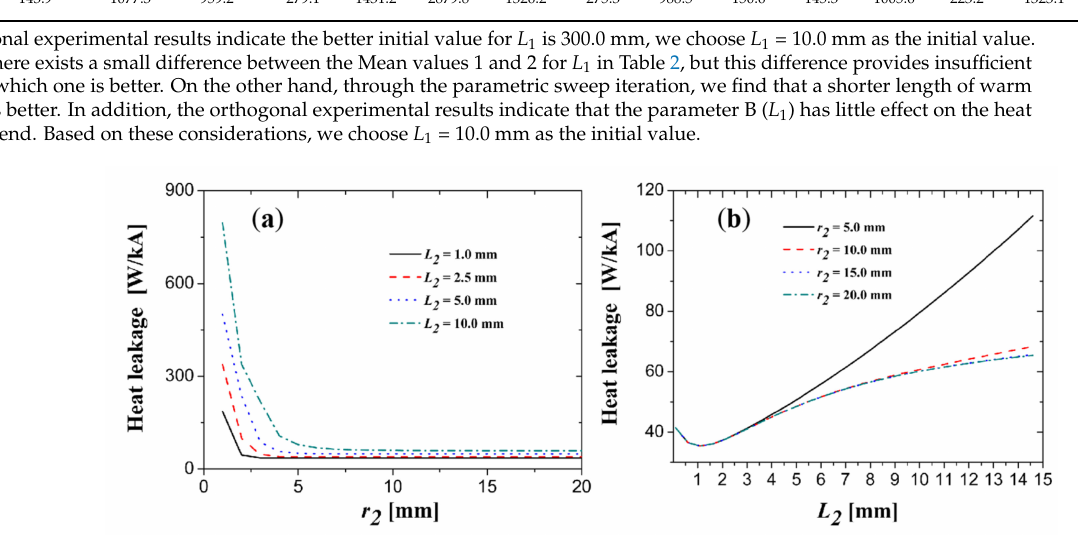
Figure 4. The coupling influence between D ( r 2 ) and E ( L 2 ) on the cold end heat leakage of